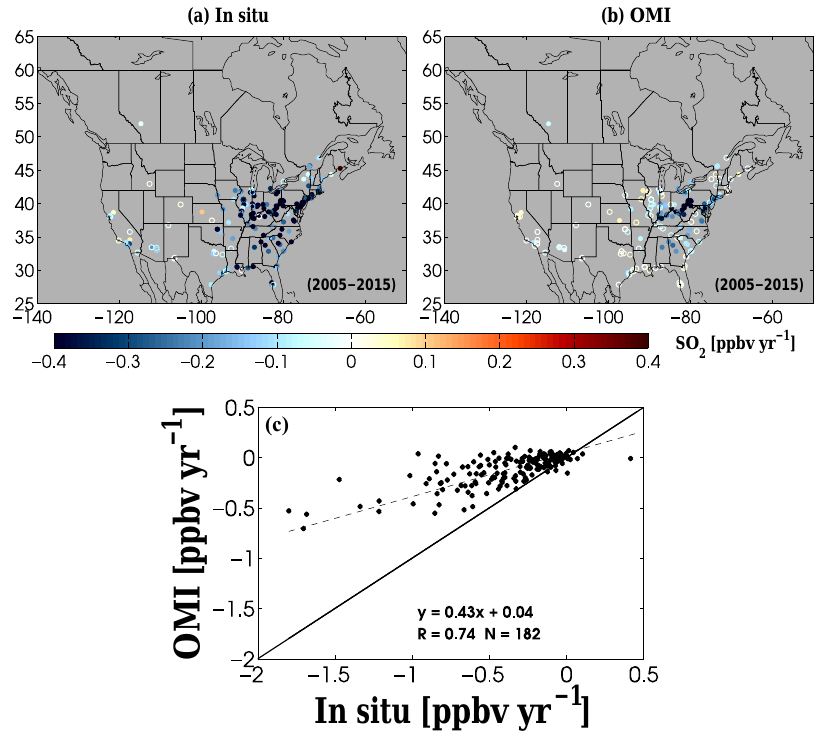
Figure 4. Trends in ground-level SO 2 for the period of 2005–2015. Panels (a, b) show trends inferred from in situ measurements at the OMI overpass and from the OMI for the period of 2005–2015. The filled circle represents where trend p values < 0.05 and trend p values > 0.05 are shown as empty circles. Panel (c) contains scatter plots of trends for the period of 2005–2015.